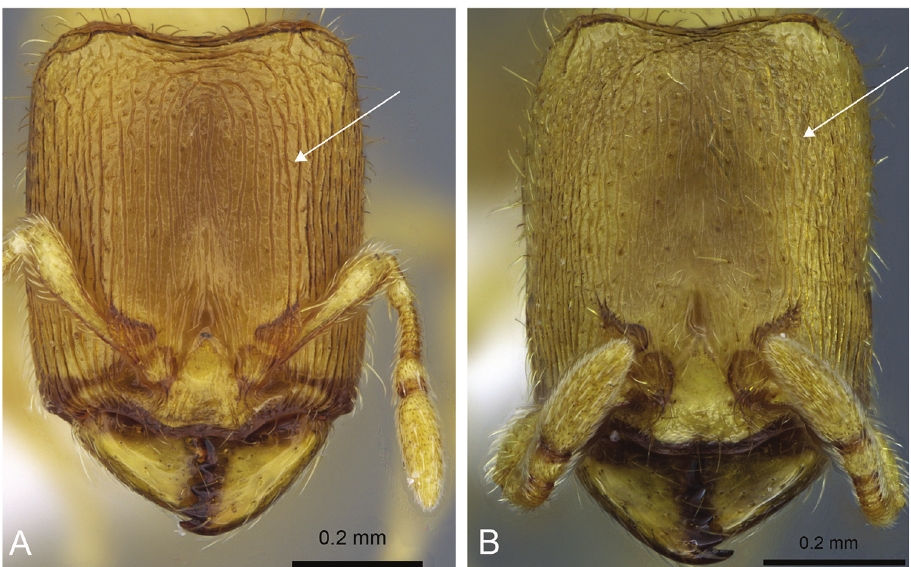
Figure 12. Head in full-face view of A Carebara demeter (CASENT0192622) B Carebara dota